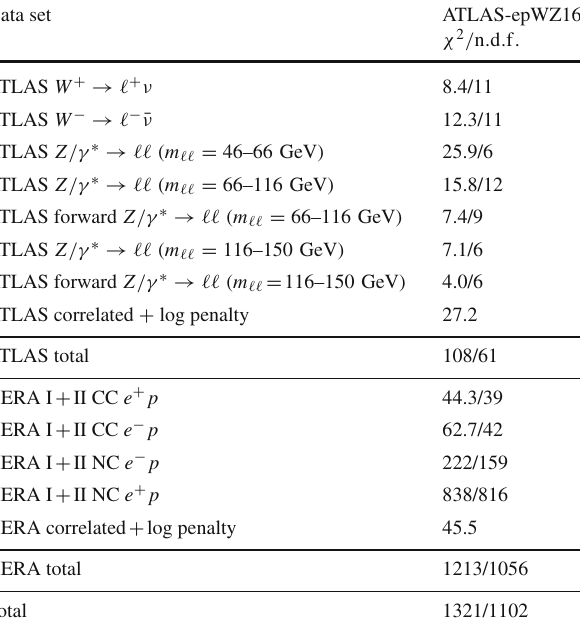
Table18 QualityoftheQCDfit,expressedasthe χ 2 / n . d . f . ,tothefinal DIS HERA data and the ATLAS differential W → (cid:3)ν and Z /γ ∗ → (cid:3)(cid:3) cross-section measurements. This NNLO fit is the base for the new ATLAS-epWZ16 set of PDFs Data set ATLAS-epWZ16